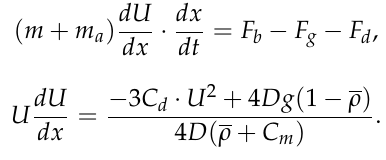
Figure 2. Free body diagram of a rising buoyant sphere.